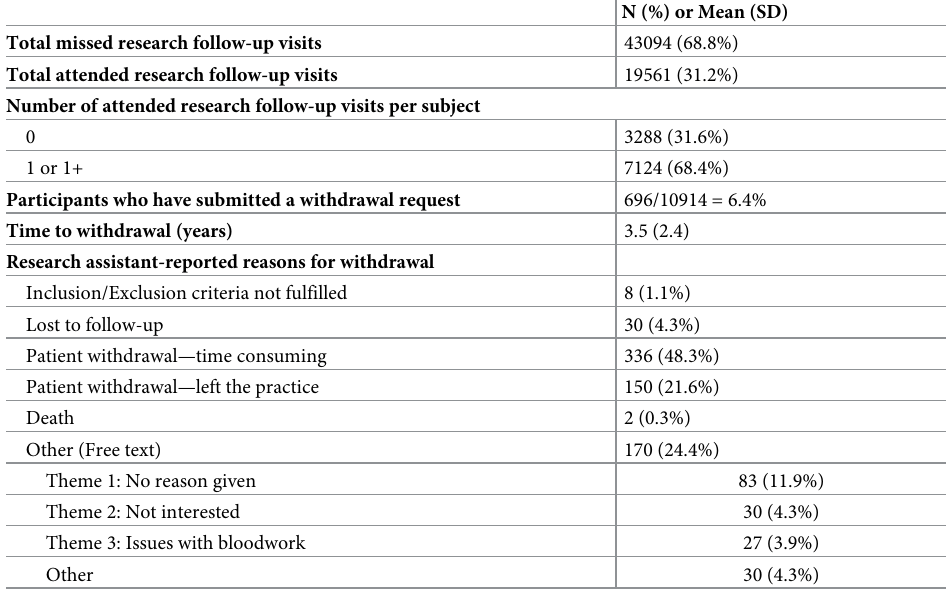
Table 3. Attendance of research follow-up visits and withdrawal from TARGet